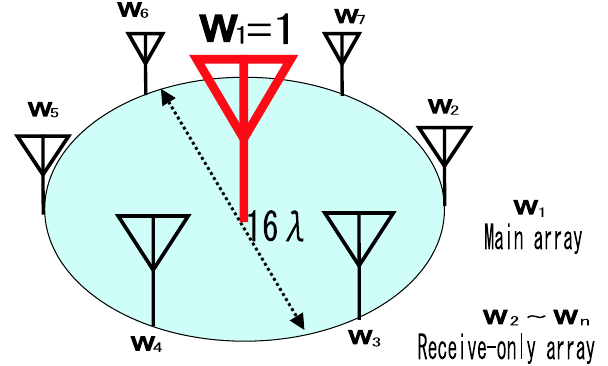
Table 1. Basic parameter of the MU radar.